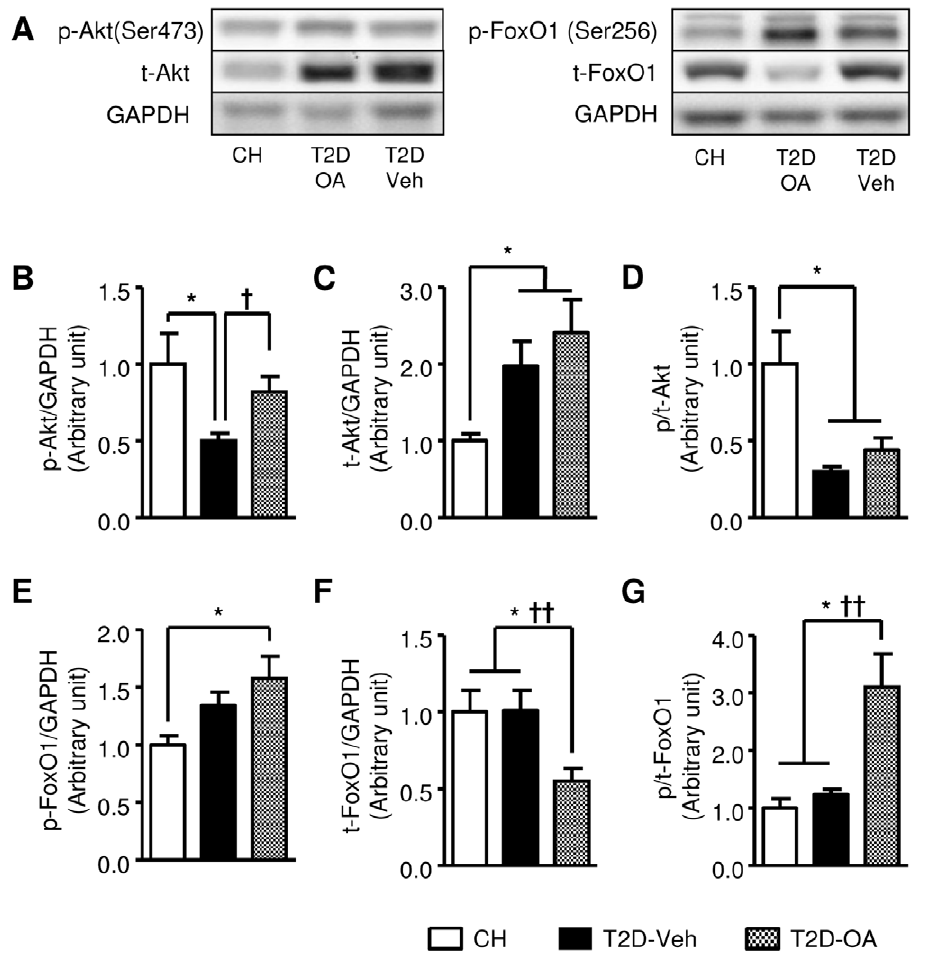
Figure 8. Changes in Akt and FoxO1 in the liver 4 weeks after the removal of OA. Four weeks after the cessation of OA treatment, mice were sacrificed following a 5–7 hour fast. Liver samples were freeze-clamped and stored at 2 80 u C for subsequent Western blotting analysis. Representative Western blot images of phosphorylated and total Akt and FoxO1( A ). Quantification of p-Akt/GAPDH ( B ), t-Akt/GAPDH ( C ), p-/t-Akt ( D ), p-FoxO1/GAPDH ( E ), t-FoxO1/GAPDH ( F ) and p-/t-FoxO1 ( G ). * p , 0.05 vs. CH; { p , 0.05, {{ p , 0.01 vs. T2D-Veh, n=6–8 per group.